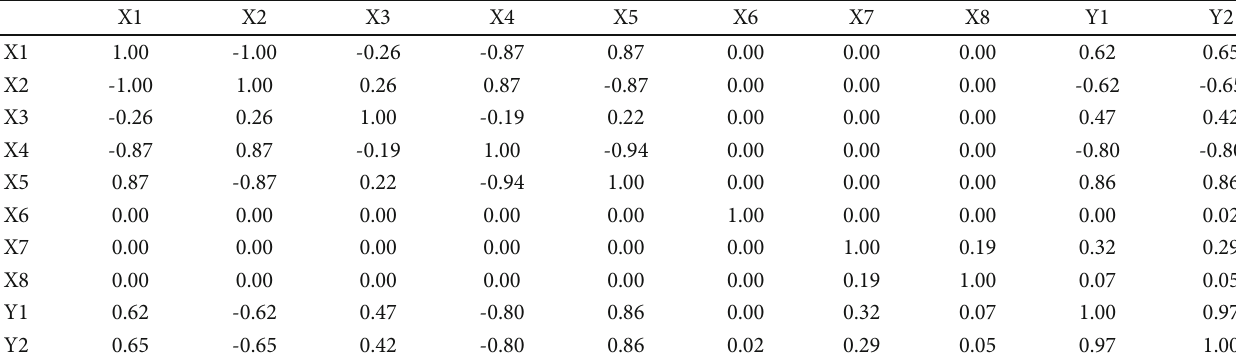
Table 3: Pearson correlation coe ffi